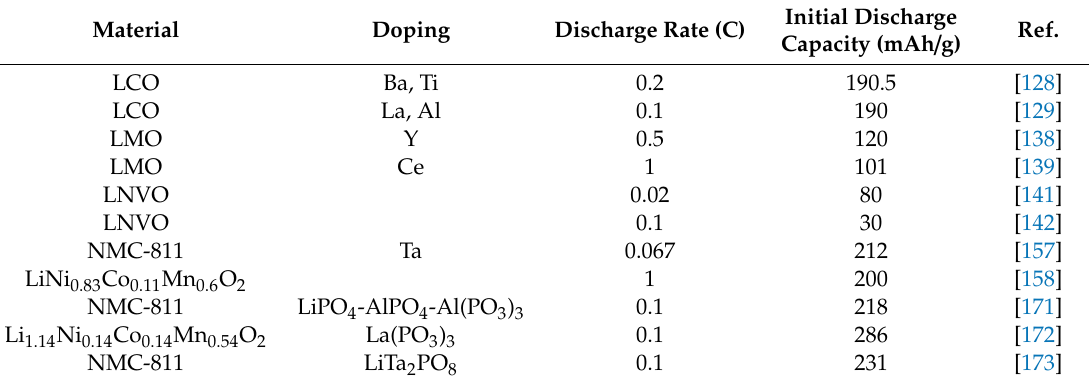
Table 2. Comparison of the discharge capacity among different cathode materials.